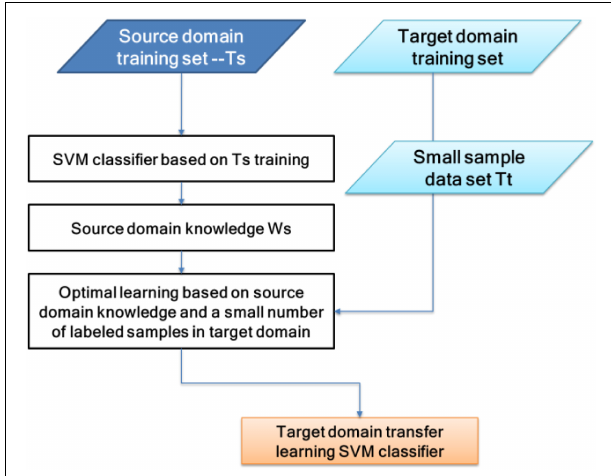
FIGURE 5 | Transfer support vector machine (TSVM) principle diagram.